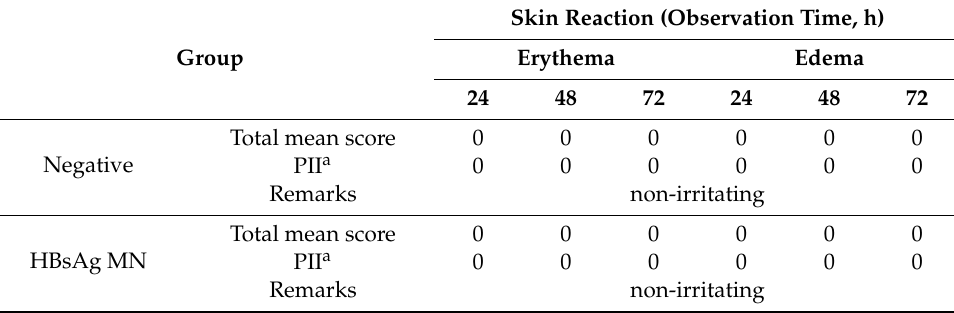
Table 2. Dermal irritation responses of MNs in rabbits ( n =